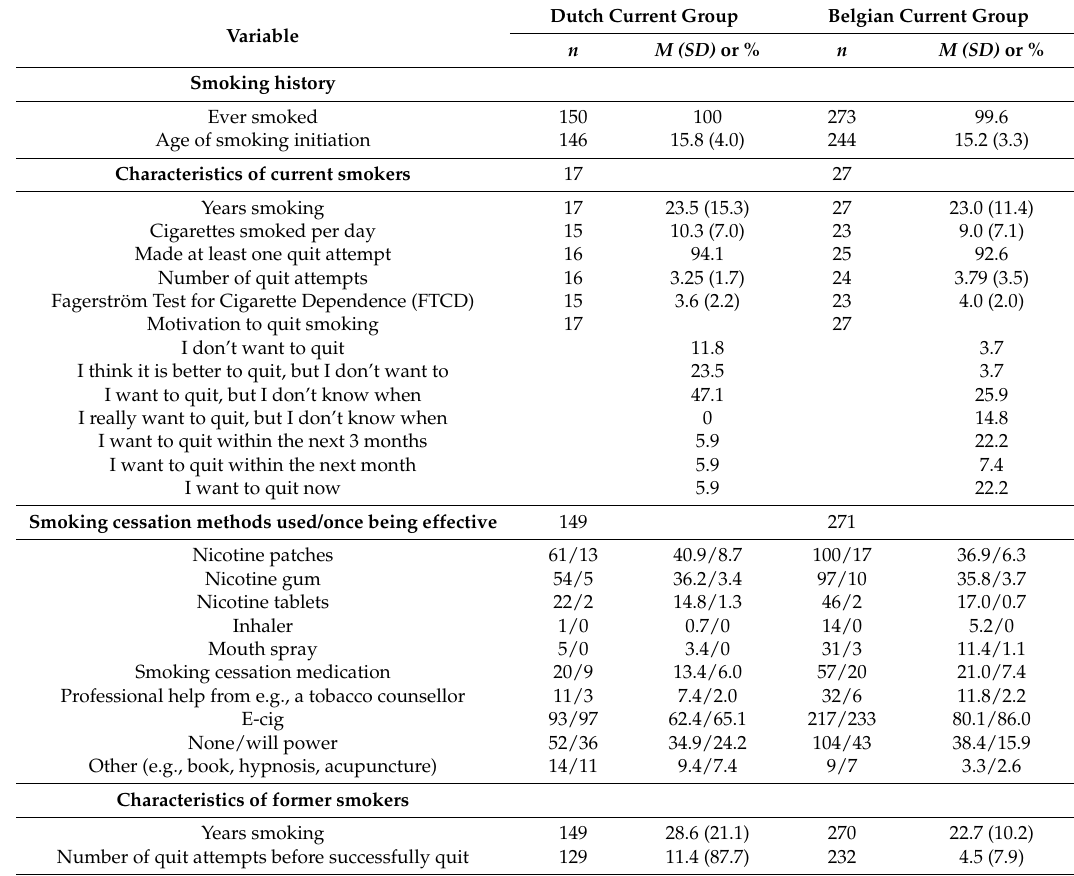
Table A2. Smoking history and current smoking